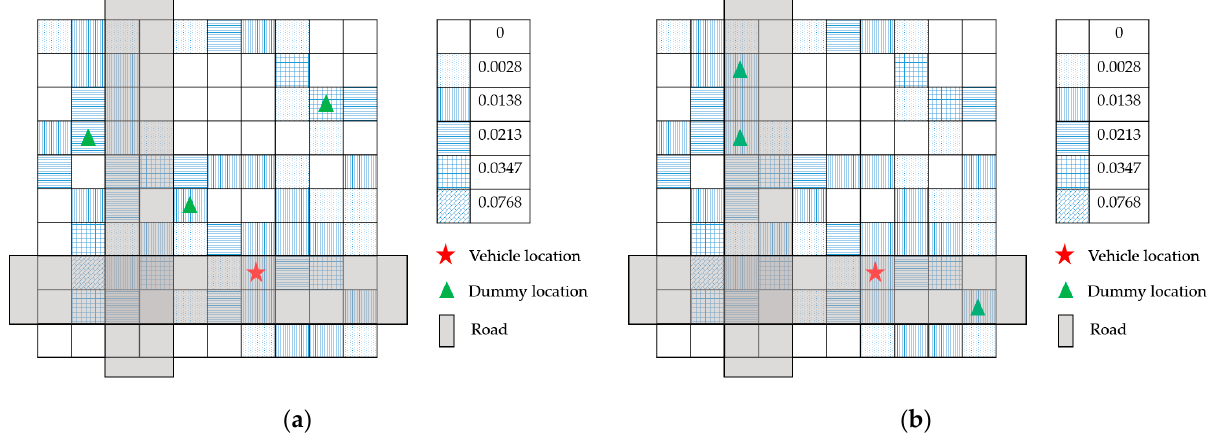
Figure 2. Service request probability distribution. ( a ) with random dummy location selection algorithm; ( b ) with dummy location selection algorithm under road restrictions.